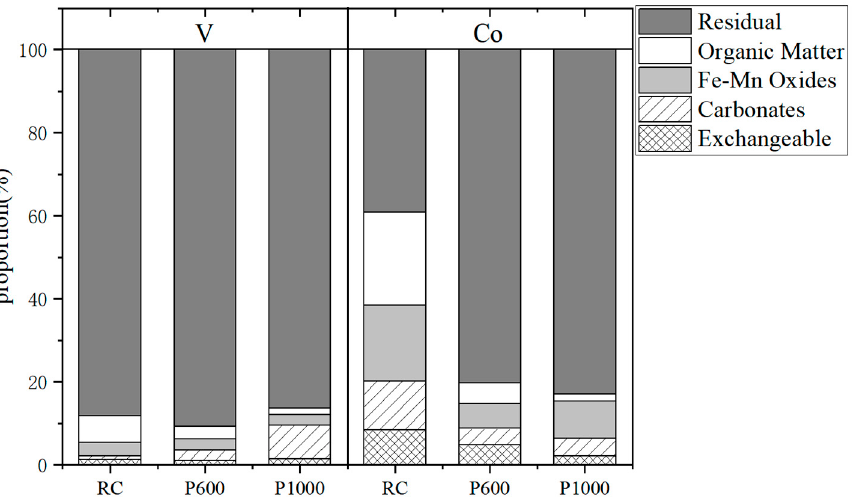
Figure 1. Speciation fractions of V and Co in stone coal (RC) and its combustion products at 600 °C (P600) and 1000 °C (P1000).